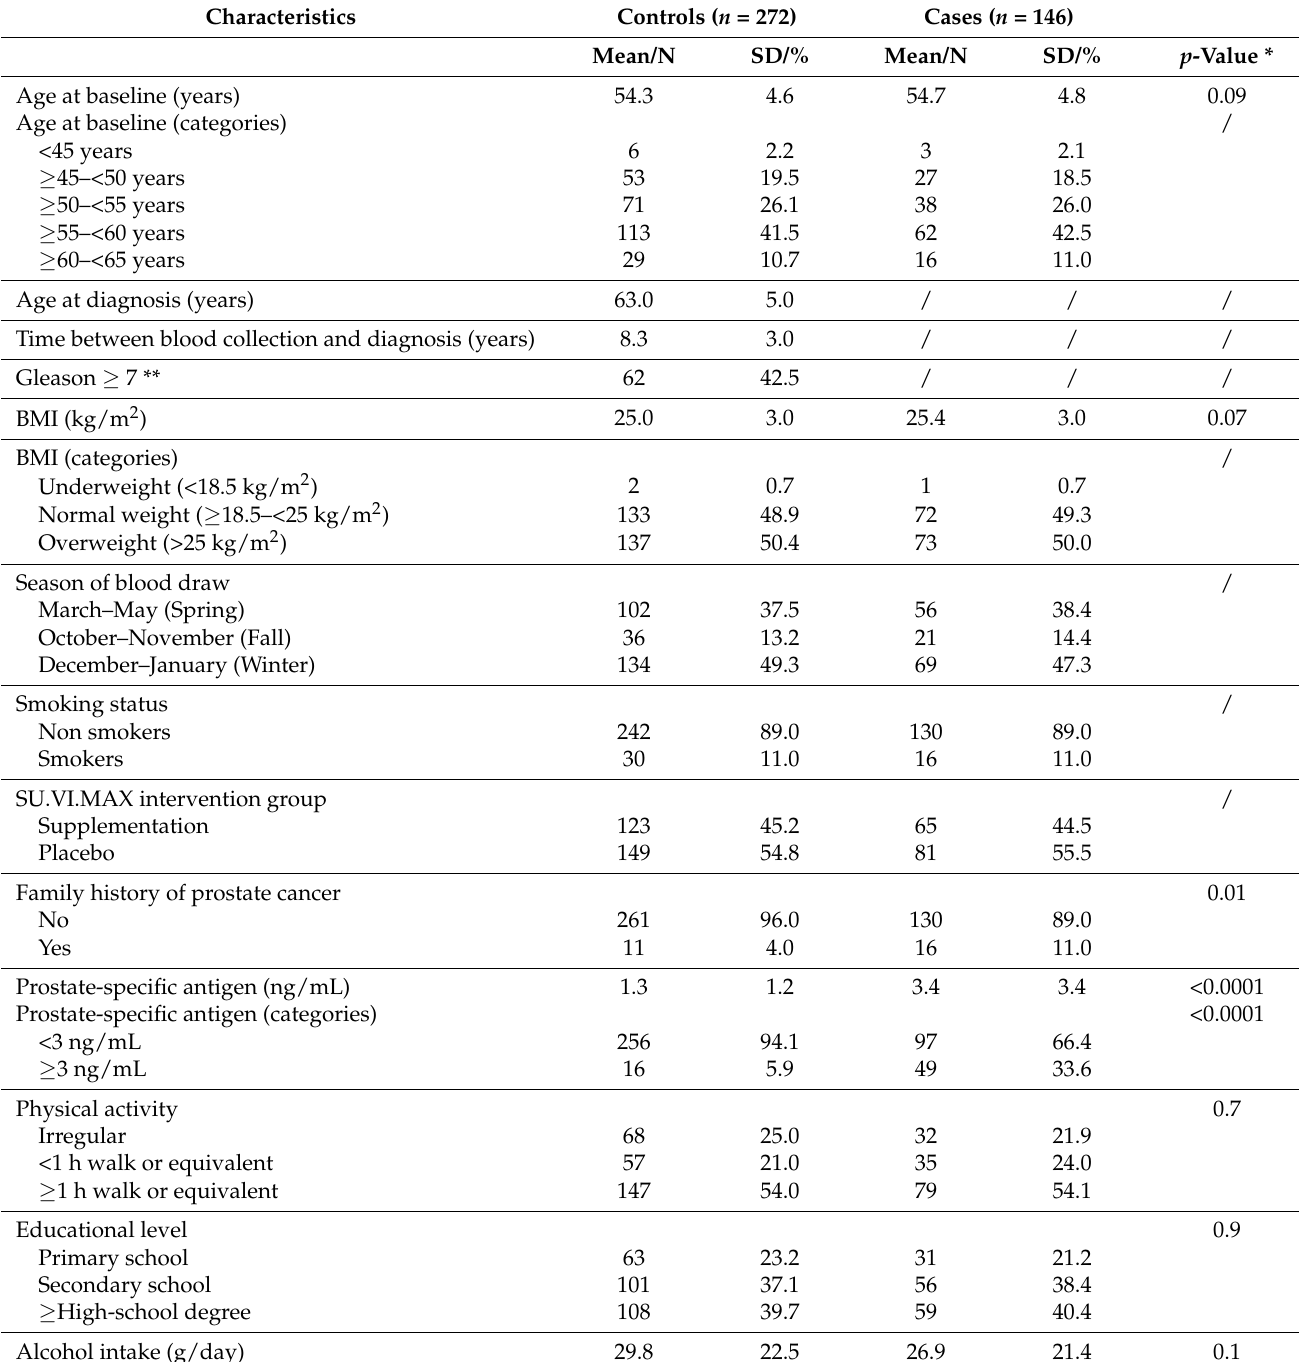
Table 1. Characteristics of prostate cancer cases and matched controls.